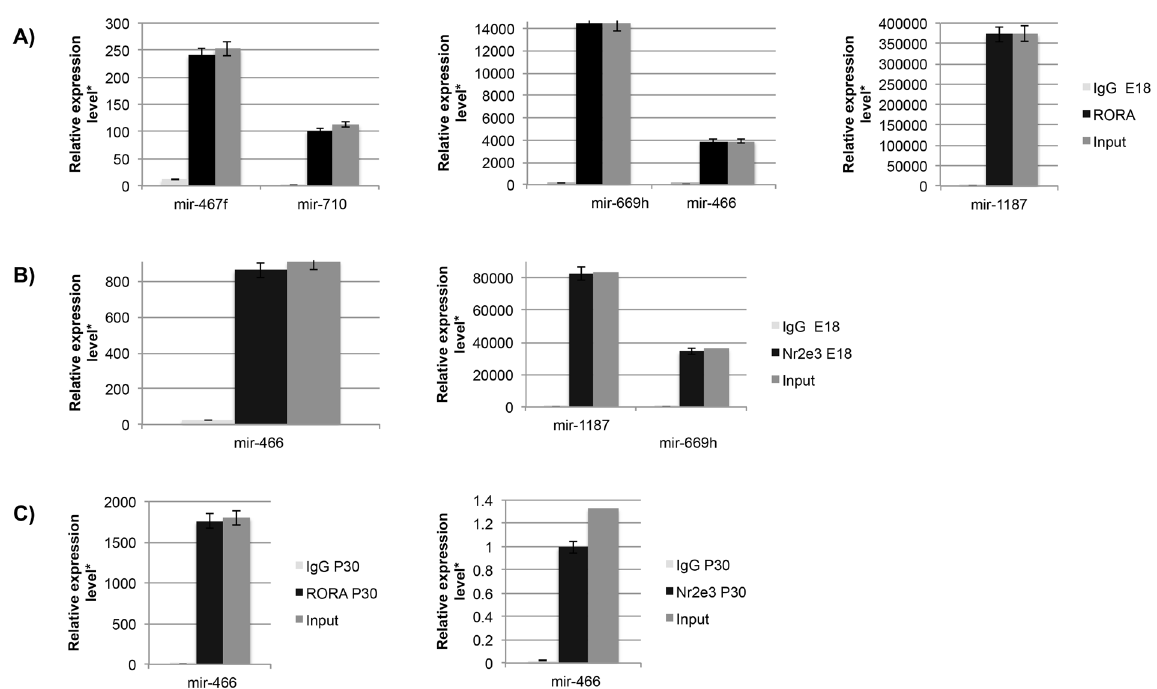
Figure 7. Chromatin IP (chIP) quantitative real time PCR (chIP-qRT-PCR) of miRNA targets for RORA and NR2E3 at E18 and P30. ( A ) RORA targeted miRNAs identified at E18 ( B ) NR2E3 targeted miRNAs identified at E18, ( C ) RORA and NR2E3 targeted miRNAs identified at E18. Input (positive control), RORA-chIP, NR2E3- chIP, and immunoglobulin G (IgG) negative control. * Relative expression is calculated as molecules/1000 molecules β -actin. Standard errors are indicated for each gene. All genes had a minimum significance of p < 0.05.